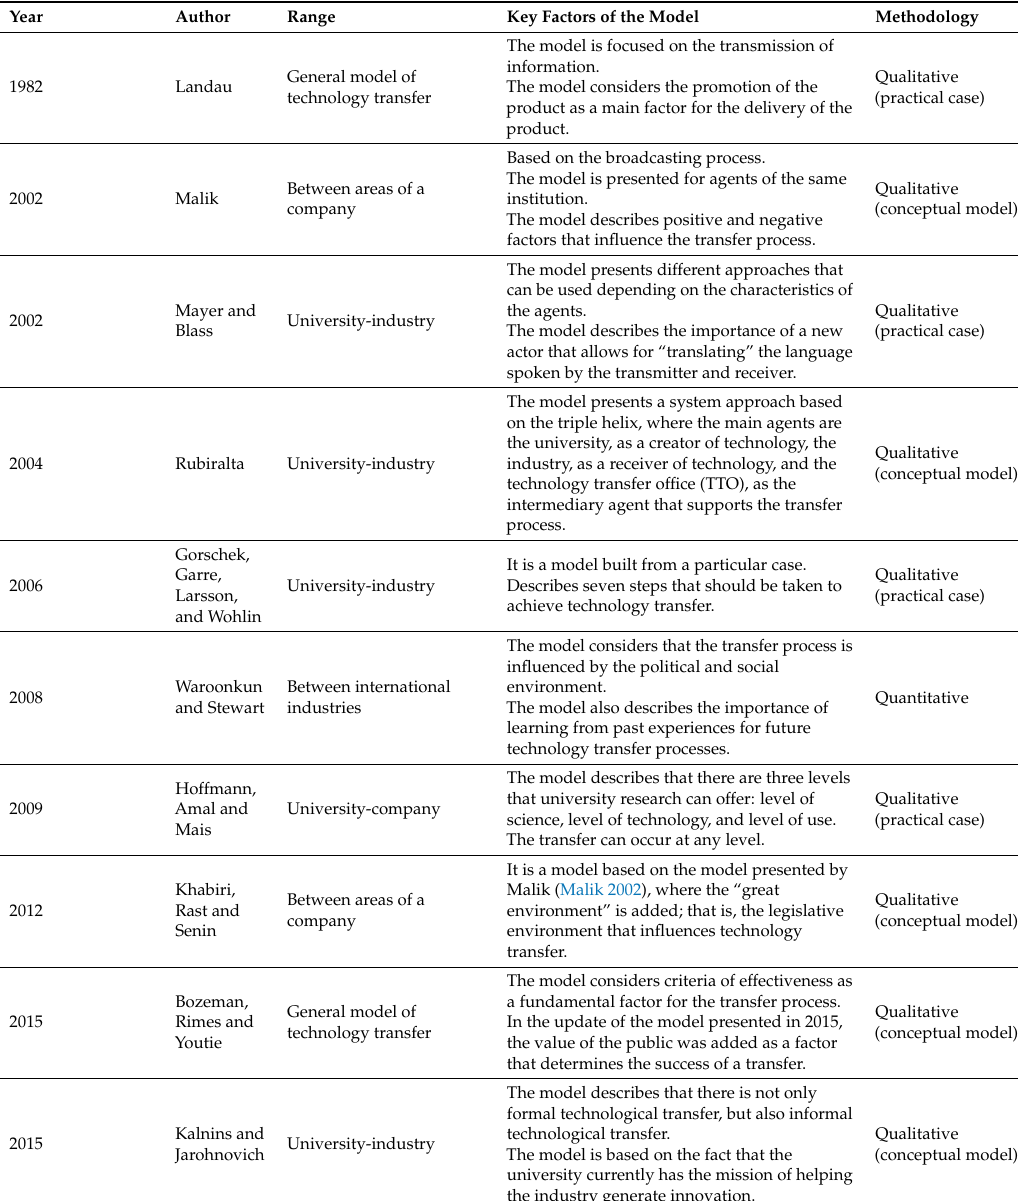
Table 1. List of models of technology transfer